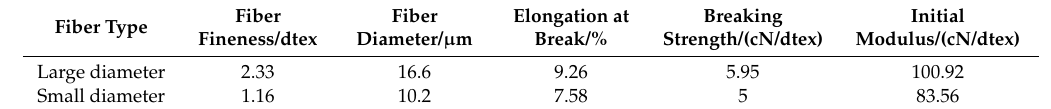
Table 1 . Mechanical properties of the plasticized spinning PAN fibers.